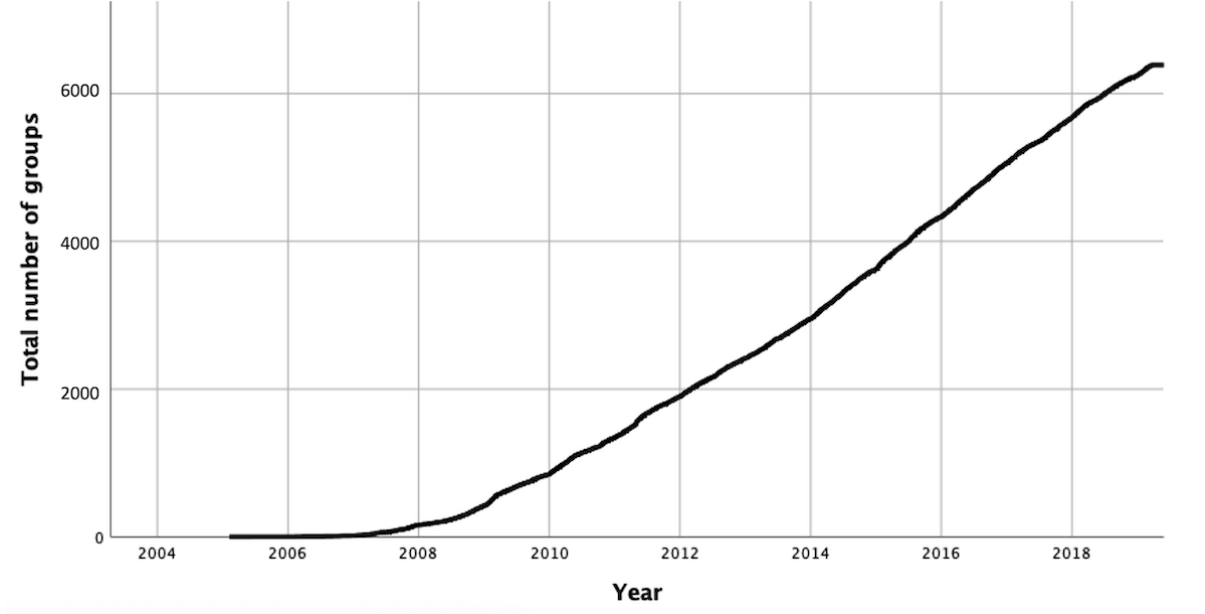
Figure 1. Development of the total number of Facebook support groups for pediatric rare diseases over time.